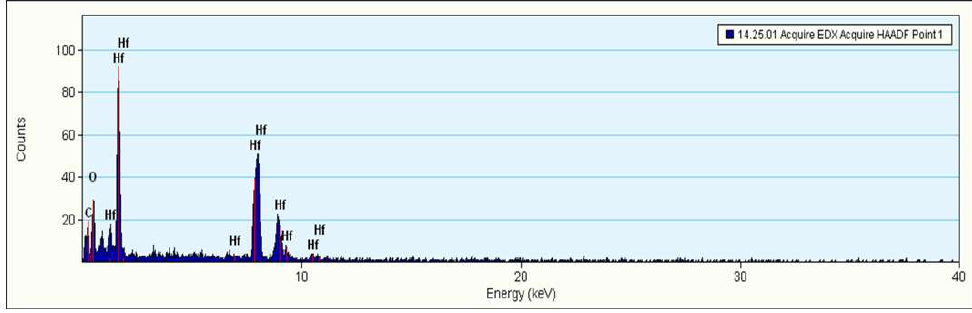
Figure 5. EDX spectrum of HfO 2 -graphene nanocomposite.